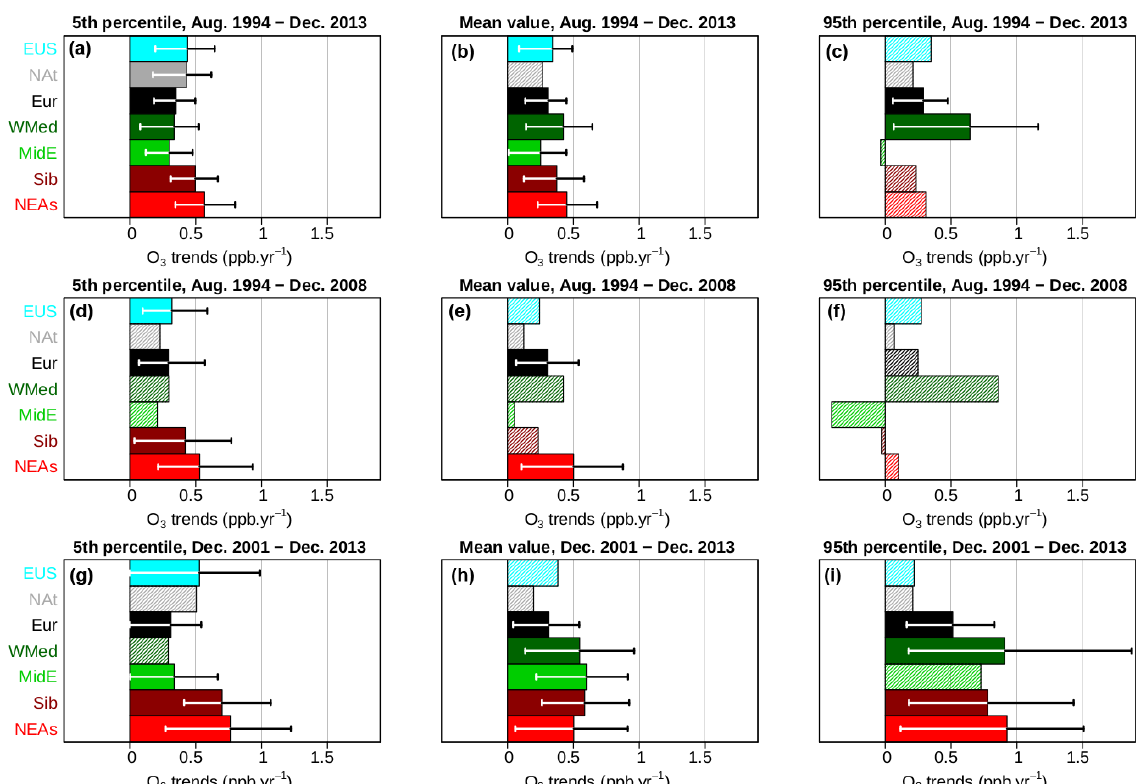
Figure 12. O 3 trends (ppbyr − 1 ) in the UT over the whole monitoring period (1994–2013: a – c ), over 1994–2008 (d–f) , and over the mon- itoring period for CO (2002–2013: g – i ) for the monthly 5th percentile (a, d, g) , mean value (b, e, h) , and 95th percentile (c, f, i) . For each significant trend, the error bars represent the 95% confidence interval. The insignificant trends are represented by hatched areas. The coloured labels correspond to the regions defined in Fig.